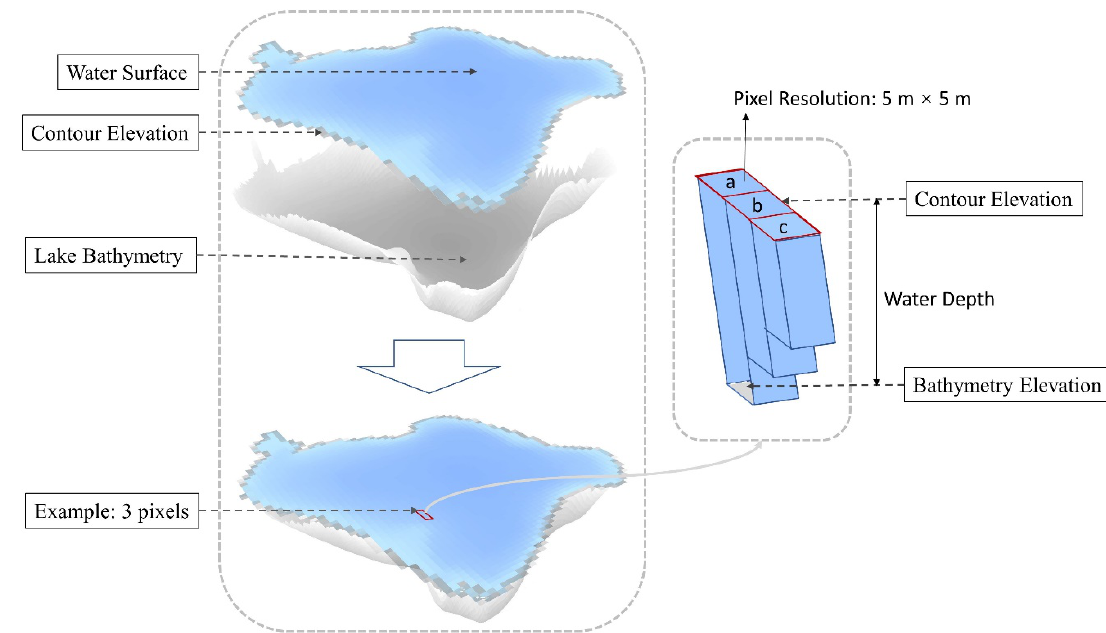
Figure 7. An illustration of lake water storage calculation.